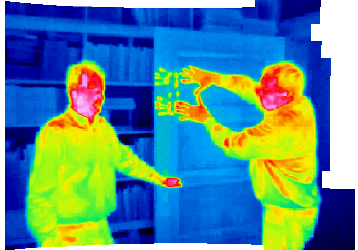
Figure 6: Visualization of the undistorted thermal infrared